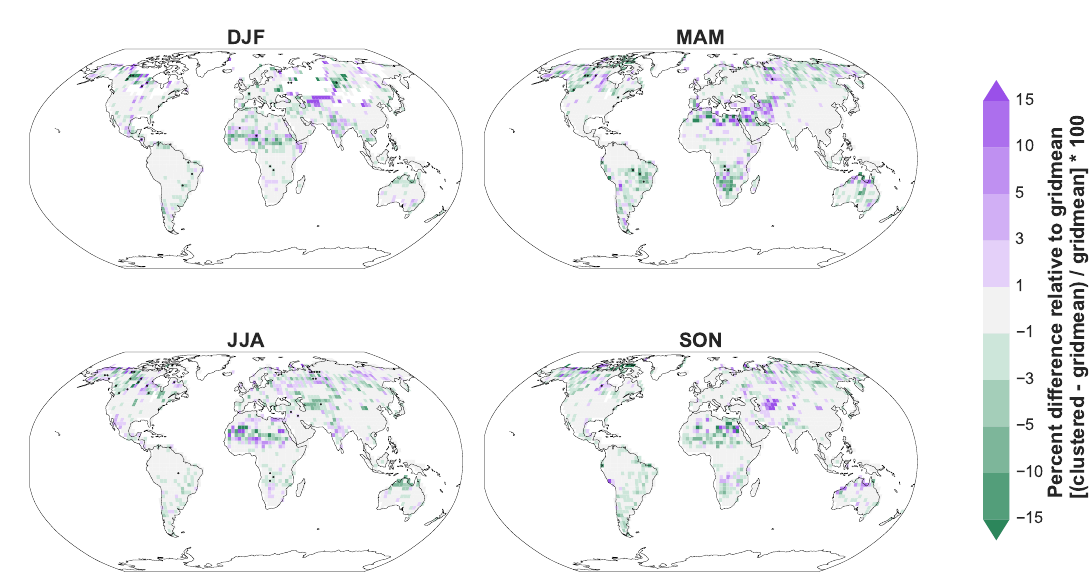
Figure A7. Percent difference in evapotranspiration (ET) between the Cluster and Gridmean simulations by season (mean of 1995–2015). Grid cells with monthly ET of < 10 − 5 mm water were masked out to prevent instances of division by zero and overly large relative differences in regions of very small evapotranspiration. Positive values indicate the Cluster simulation ET is larger while negative values indicate the Gridmean simulation ET is larger. Dots indicate grid cells that are statistically significant (independent two-sample t -test p level < 0 . 01).